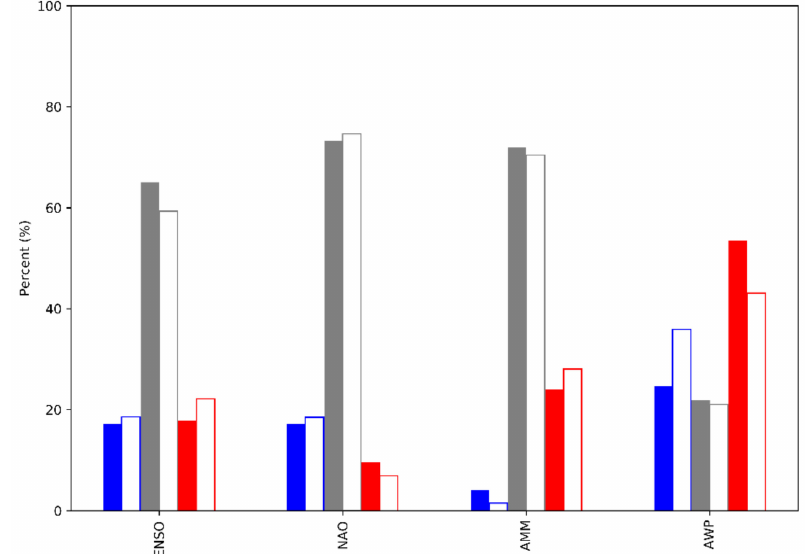
Figure 13. Percentages of TCs generated during negative, neutral, and positive phases of ENSO, NAO, AMM, and during smaller, normal, and larger AWP (filled blue, grey and red bars, respectively); and percentage TC rainfall contributions under each phase of ENSO, NAO, AMM, and AWP, shown by blue, grey, and red hollow bars. Period